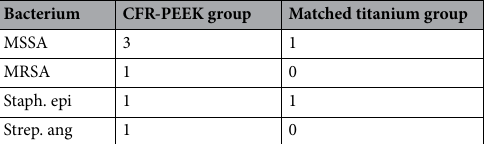
Table 4. Bacterial spectrum of cases with screw loosening. Bacteria causing initial spondylodiscitis of cases with screw loosening. MSSA = Methicillin sensible Staphylococcus aureus ; MRSA = Methicillin